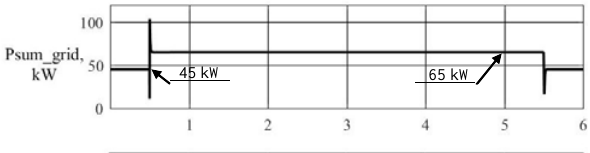
Figure 6. Experiment: transient process with ESS in the Power Limit Mode (from top to bottom - the power of the DGU, the load power)